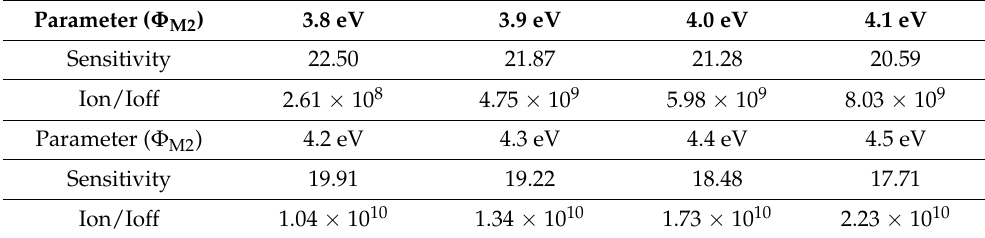
Table 3. The variation of sensitivity and switch ratios with different Φ M2 (Vgs = 2.0 V, Vds = 1.0 V, Φ Φ M1 = 4.3 eV, PG = 5.9 eV).